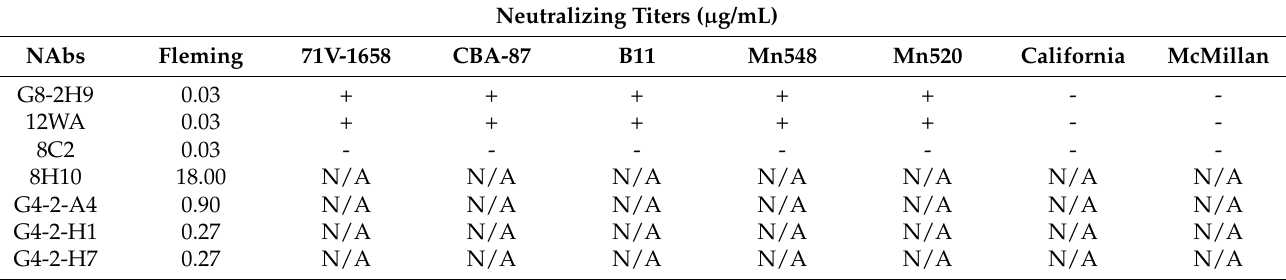
Table 2. Anti-WEEV